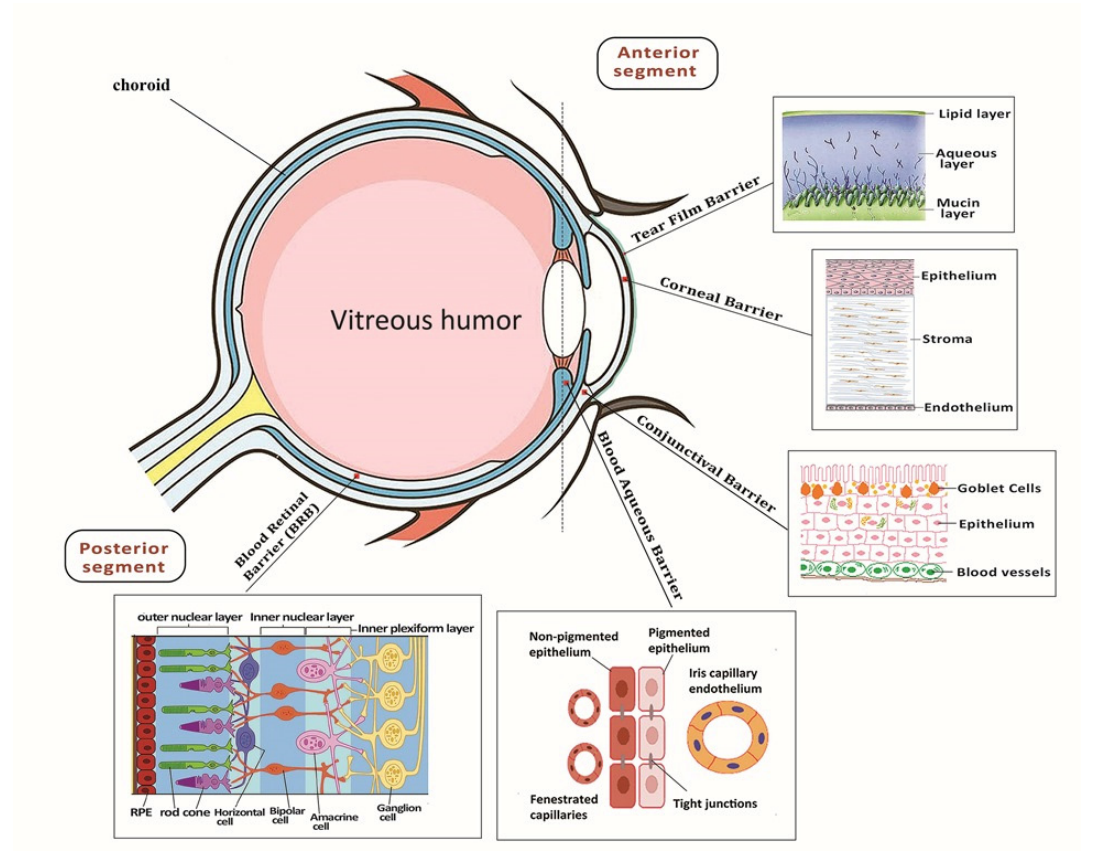
Figure 1. Depiction of eye anatomy and its associated barriers. It can be classified into two segments, anterior segment and posterior segment, which occupy one-third and two-thirds, respectively. The tear film, cornea and conjunctiva have limited diffuse topical delivery. The posterior segment is composed of the sclera, choroid and retina.